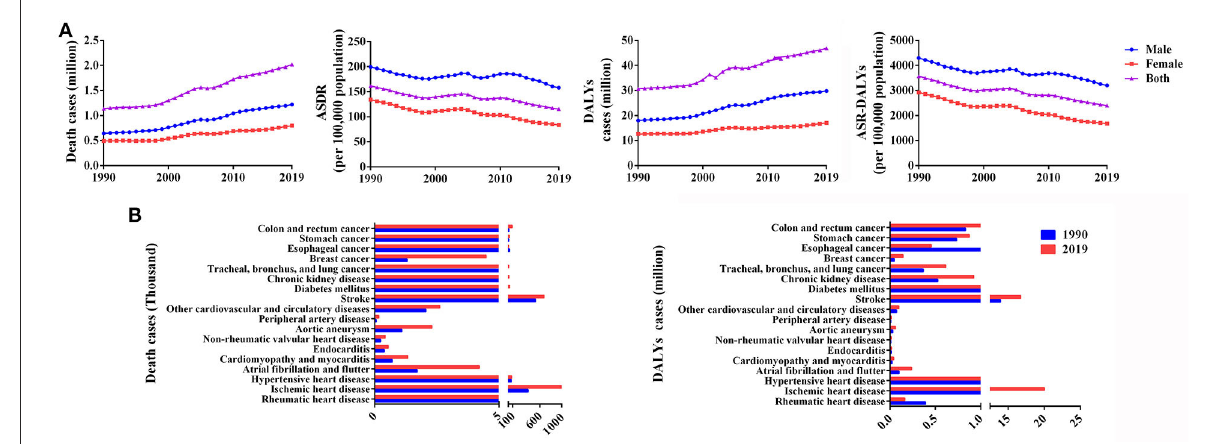
FIGURE1 Overall effects of dietary risks on health in China from 1990 to 2019. (A) Deaths, ASDR, DALYs, and ASR-DALYs by sex from 1990 to 2019. (B) Deaths and DALYs in individual diseases in 1990 and